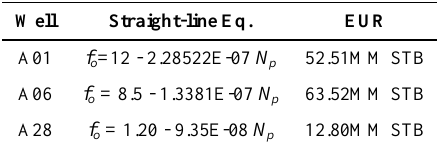
Table 5. EUR from f o versus N